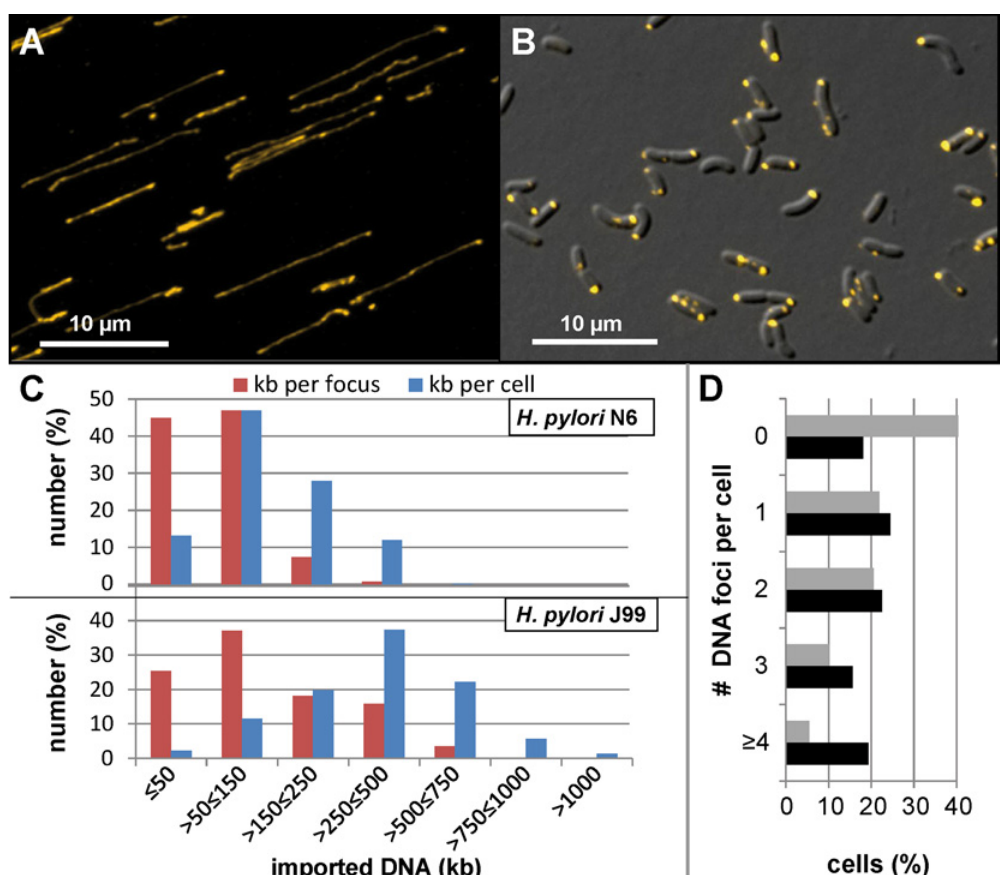
Fig 2. Quantification of imported DNA into H . pylori cells. A, Cy3 image of single Cy3-labelled λ DNA molecules, stained in yellow; B, DIC/Cy3 overlay image of H . pylori J99 after 10 min of DNA uptake under microaerobic conditions; C, results of the quantitative analysis of DNA uptake. For H . pylori , fluorescence intensity in single DNA foci (red) and in whole cells (blue) was determined in two different wild type strains (N6 and J99) after microaerobic growth in TSB-FBS into competent phase. D, histogram of the number of foci per cell. Grey bars, strain N6; black bars, strain J99. Fluorescence intensity was compared to that of single λ DNA molecules and expressed as imported kb. The images were acquired using a Zeiss Axio Observer Z1 and ZEN software, blue edition, version 2.0.0.0. n cells = 928 or 1483 and n foci = 1903 or 1740 were analyzed for J99 or N6,